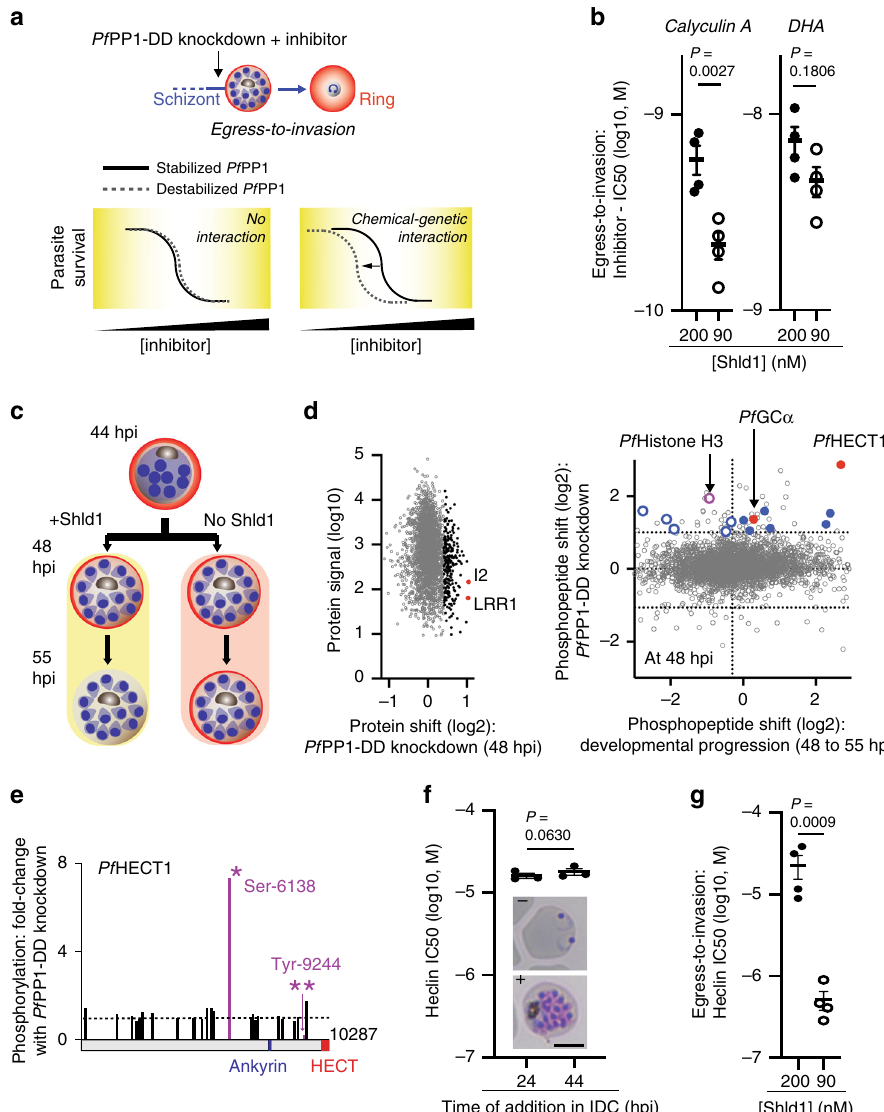
Fig. 3 P f PP1 regulation of a HECT E3 protein-ubiquitin ligase for egress. a Chemical-genetics of Pf PP1-DD. We assessed functional interactions between inhibitor-sensitive processes and Pf PP1 from shifts in chemical sensitivity induced by knockdown of the phosphatase. b The sensitivities (IC50s) of Pf PP1- mediated egress-to-invasion to calyculin A and dihydroartemisinin (DHA) at 200 or 90 nM Shld1. Mean± s.e.m.; n = 4 experiments; two-tailed t t est. c Scheme for phosphoproteomic analysis of Pf PP1-DD knockdown late in the IDC, with samples obtained at 48- and 55-hpi. d Left: At 48 hpi, signal intensities of individual proteins and shifts with Pf PP1-knockdown. Pf I2 and Pf LRR1 are indicated in red, with the top 5% of upregulated proteins indicated in black. Right: For all phosphopeptides detected in late-stage parasites, a plot of changes in levels with Pf PP1-DD knockdown at 48-hpi ( y- axis) versus changes with development from 48 to 55-hpi in parasites on-Shld1 (x-axis). Thresholds for twofold increased and decreased phosphorylation (log 2 = 1, y -axis) with knockdown are indicated. Upregulated phosphopeptides from gene products increased in transcription at the schizont-stage 16 are colored; phosphopeptides in the upper-right quadrant (developmental progression threshold: median value, x- axis) least likely to be affected by secondary, developmental-progression defects (Supplementary Note 1) are indicated with fi lled circles. The phosphorylation site from Pf Histone H3 is purple; the sites from Pf HECT1 and Pf GC α are in red. Representative of 1 experiment. e Schematic of the predicted domains of Pf HECT1 protein. We show all phosphosites detected in our study with magnitude of change with Pf PP1-DD knockdown at 48 hpi as in d . The most increased (Ser-6138) and decreased phosphorylation sites (Tyr-9244) are indicated with symbols [*] and [**], respectively. f Sensitivity of Pf PP1-DD parasites on-Shld1 (0.5 µ M) to heclin administered at the midpoint (24 hpi) or late in the IDC (44 hpi), determined from erythrocyte re-invasion. Mean± s.e.m.; n = 3 experiments; two-tailed t test. Representative images of parasites at 55-hpi + / − heclin administration (100 µ M) at 44 hpi, are shown. Scale bar: 5 µ m. g The sensitivity of Pf PP1- mediated egress-to-invasion to heclin, as in b . Mean± s.e.m.; n = 4 experiments; two-tailed t test. Source data are provided as a Source Data fi essential for egress 47 – 50 . Given the function we identi fi ed for (Fig. 4b). To understand the functional signi fi cance of Pf PP1 for Pf PP1 in egress and phosphoregulation of Pf GC α , we measured cGMP-stimulated egress, we implemented chemical-genetics to the effect of Pf PP1-DD knockdown on cellular cGMP levels, test for functional interaction with components of signal trans- fi nding that destabilization of the phosphatase enzyme reduces duction related to the second messenger. To induce cGMP in the second messenger in schizont-stage parasites by ~2-fold parasites late in the IDC, we used zaprinast, a phosphodiesterase